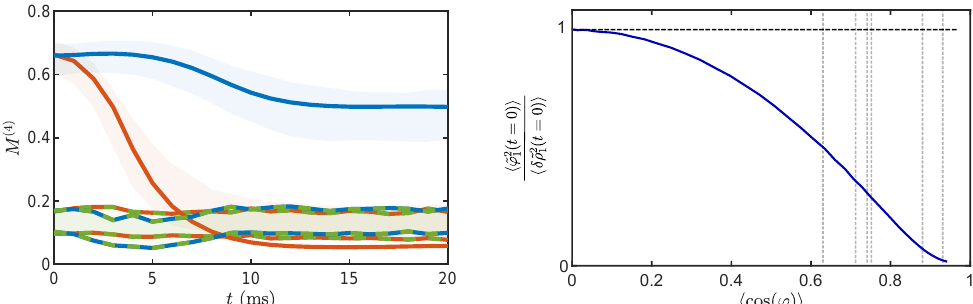
Figure 15: Left: Time evolution of M ( 4 ) in a theoretical simulation of the experiment for typical parameters. The simulations are based on a stochastic method for the construction of thermal states of the classical sine-Gordon model [ 27 ] , followed by TLL dynamics. The parameter values of the theoretical model used here have been estimated from the experimental data as discussed in detail in [ 24 ] . The red line corresponds to one of the non-Gaussian initial states and its dynamics agrees very well with those observed in the experiment. The blue line corresponds to the artificial dynamics of the same initial state if the contribution of density correlations is ignored. Equivalently, it corresponds to an initial state with the same phase fluctuations but with the initial density fluctuations set to zero. The dashed lines correspond to Gaussian fluctuations with finite statistics and set the bias level. Right: CFA estimate of the ratio of phase over density initial fluctuations of the lowest cosine mode, calculated in thermal states of the sine-Gordon model as a function of the coherence factor 〈 cos φ 〉 , which is monotonically increasing for increasing coupling J . The gray vertical lines indicate the values corresponding to the experimental initial states (c.f. Fig. 3). We observe that in this parameter range the estimated ratio varies between 1 / 2 and close to zero, values consistent with the tomographic estimates of Fig. 9. For higher modes the corresponding ratio is always larger than that of the first mode. This suggests that even for moderately small values of the ratio, the corresponding time evolution shown on the left exhibits a significant decrease of non-Gaussianity comparable to the experimental